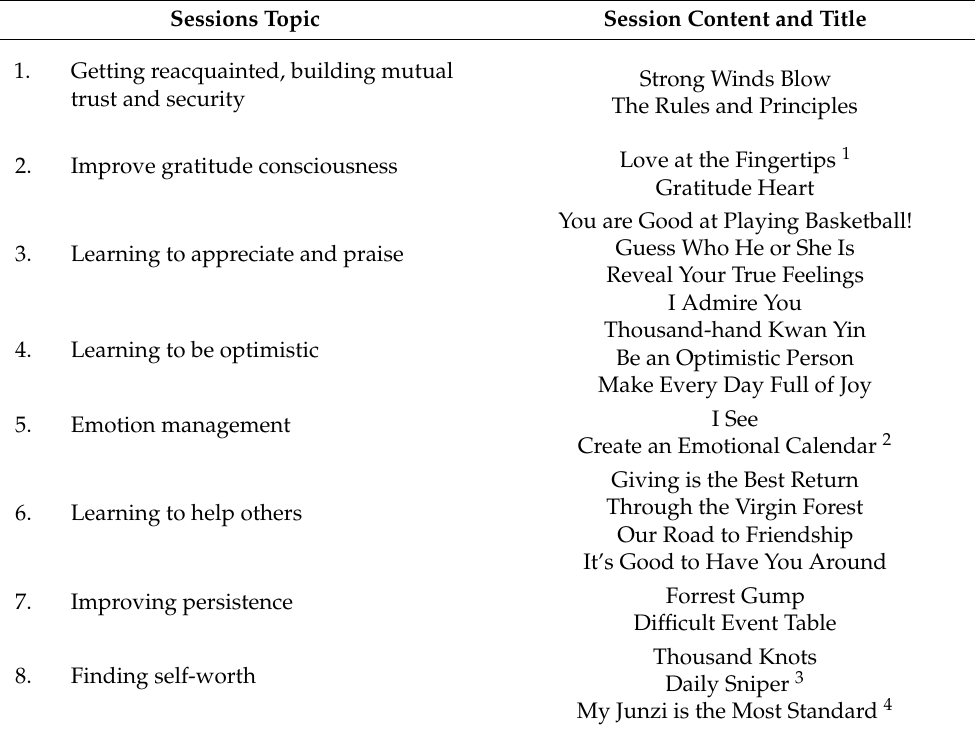
Table 1. Growth psychoeducation intervention (GPI) session topics and content